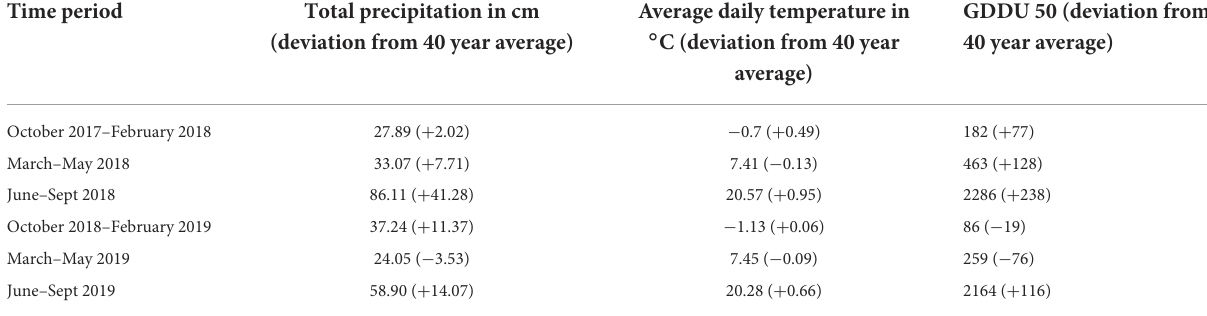
TABLE 2 Weather data collected at UW-Madison Arboretum Weather Station, 2018 and 2019. Time